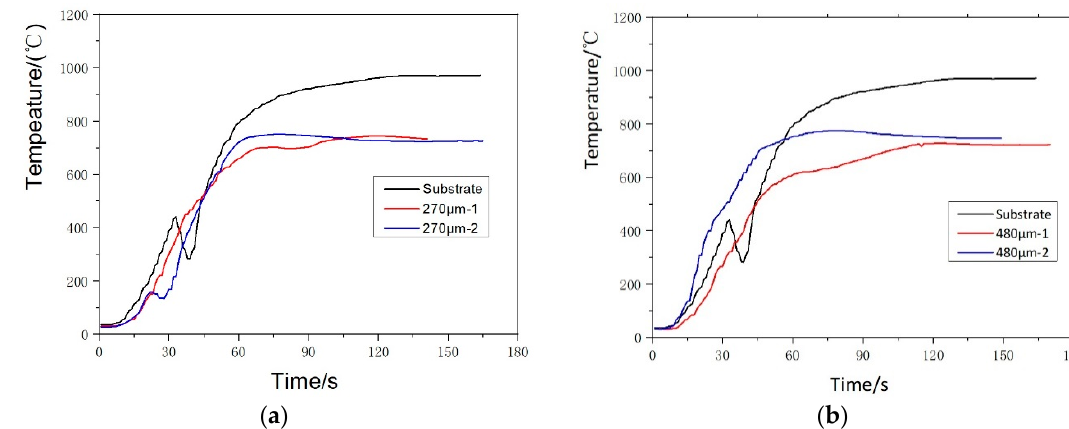
Figure 6. Thermal barrier effect of Yb 2 O 3 -Gd 2 O 3 co-doped YSZ coatings with different thickness: ( a ) 270 μ m coatings, ( b ) 480 μ m coatings.